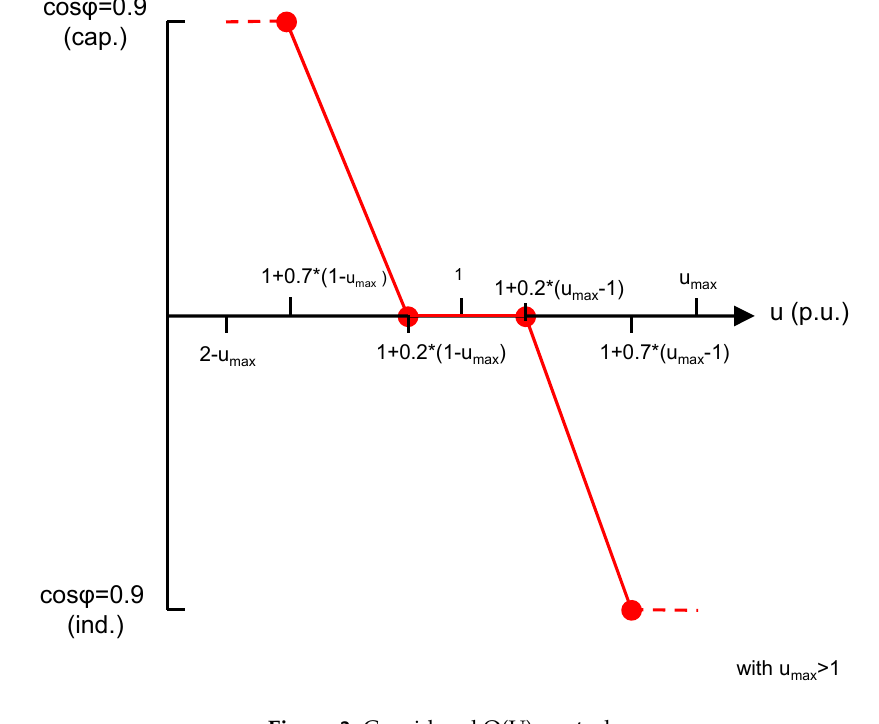
Figure 3 . Considered Q(U)-control. Figure 3. Considered